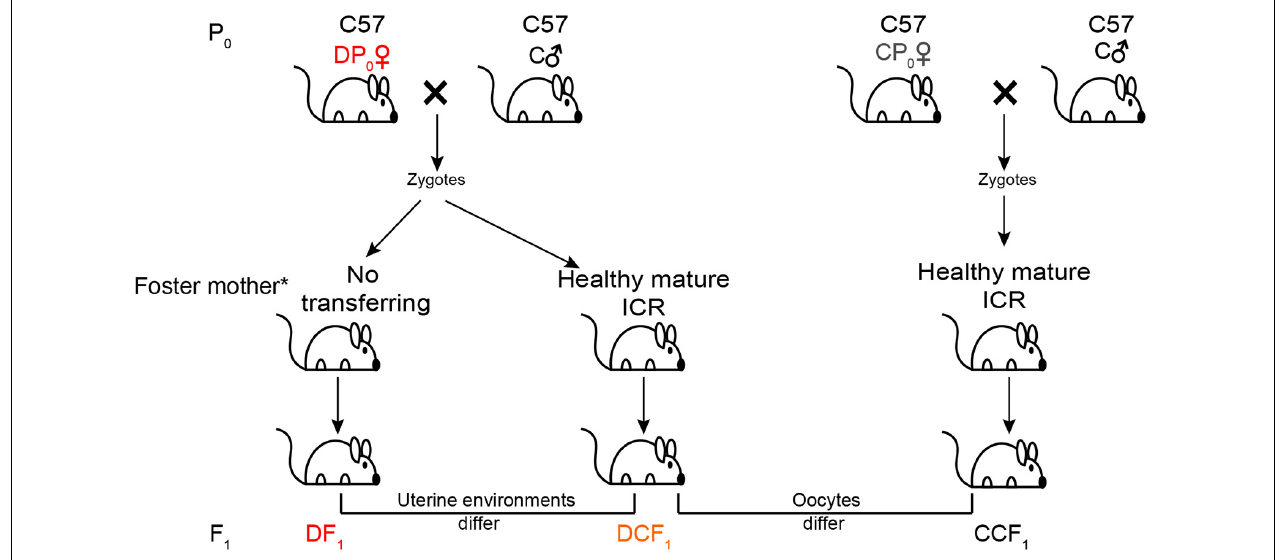
FIGURE 1 | Experimental design. Maternal C57BL/6J mice (P 0 ) were at random allocated to induce or not induce diabetes. The diabetic mice (DP 0 ) and non-diabetic mice (CP 0 ) were mated with normal C57BL/6J males (C ) and their zygotes were collected and transferred into the oviduct of healthy mature ICR foster mother. For the other part of successfully mated DP 0 mice, their zygotes were not transferred and incubated in the original diabetic uterus of DP 0 . Newborn ♂ offspring (F 1 ) of these three group were all fed by ICR foster mother. All offspring were weaned at 3 weeks of age and placed on a normal diet. *All offspring were breast fed by ICR